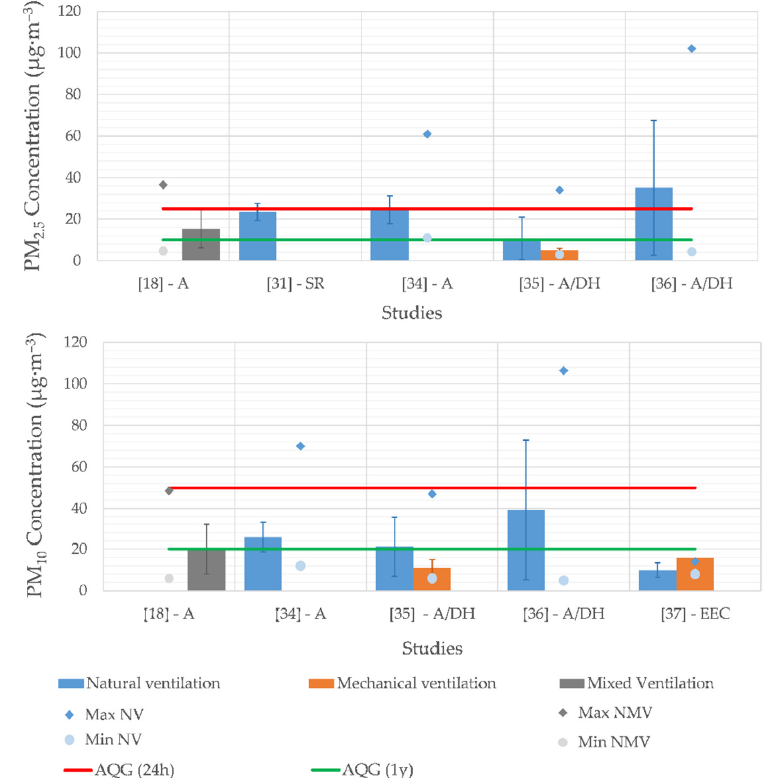
Figure 8. PM 2.5 ( top ) and PM 10 ( bottom ) levels monitored during the sleep period for three types of ventilation setting. Studies index is regarding type of building: A—apartment;